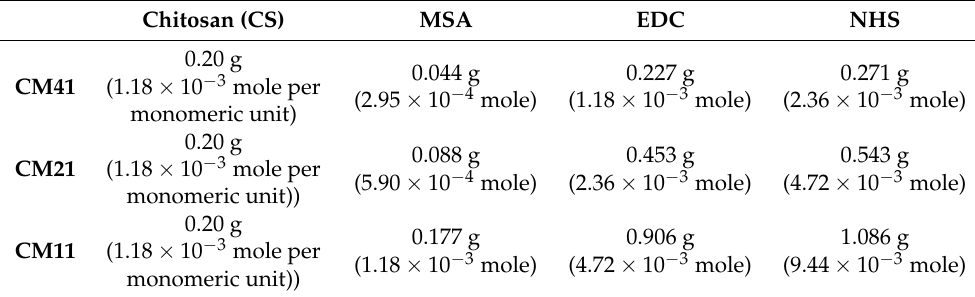
Table 1. The chemical formulation for preparing the crosslinked chitosan, CMxy.